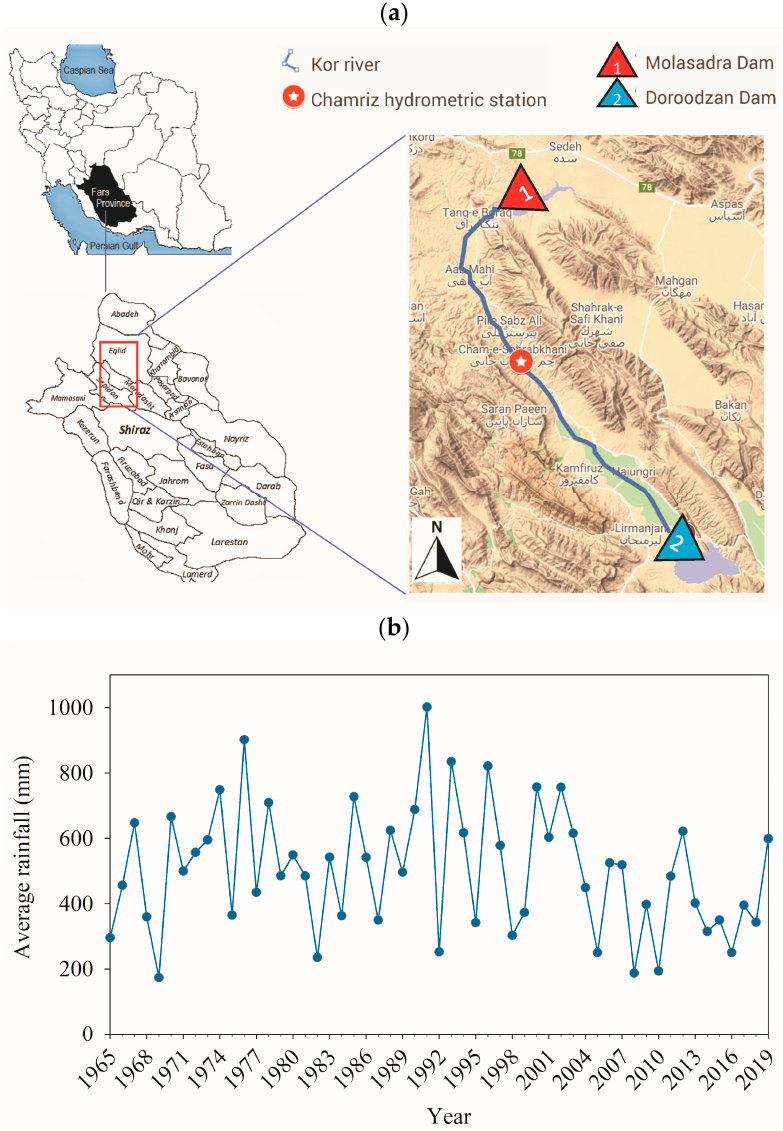
Figure 2. ( a ) Location of the study area, upstream reach of the Kor River. ( b ) Temporal variations of the average yearly rainfall.